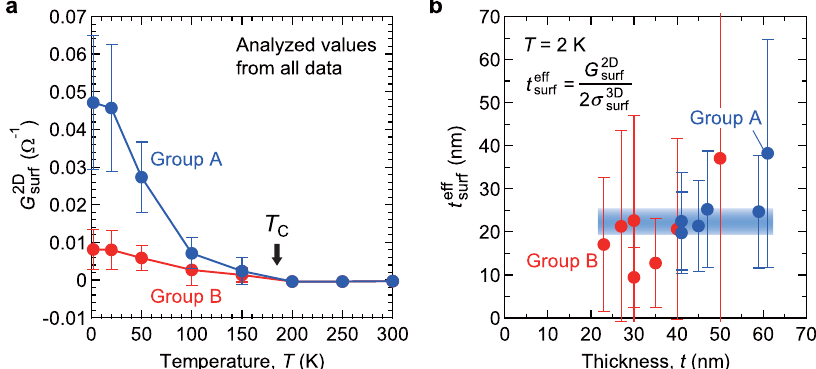
Fig. 3 Analyzed conductance for bulk and surface in Co 3 Sn 2 S 2 thin fi lms. a , b The σ 3D Group A and B as shown in Fig. 2c, d. Temperature dependence of the analyzed σ 3D fi lm #1 in A and #2 in B (black line). The deviation between the black line and σ 3D σ 3D . The error bars represent the standard deviations of the calculated σ 3D surf